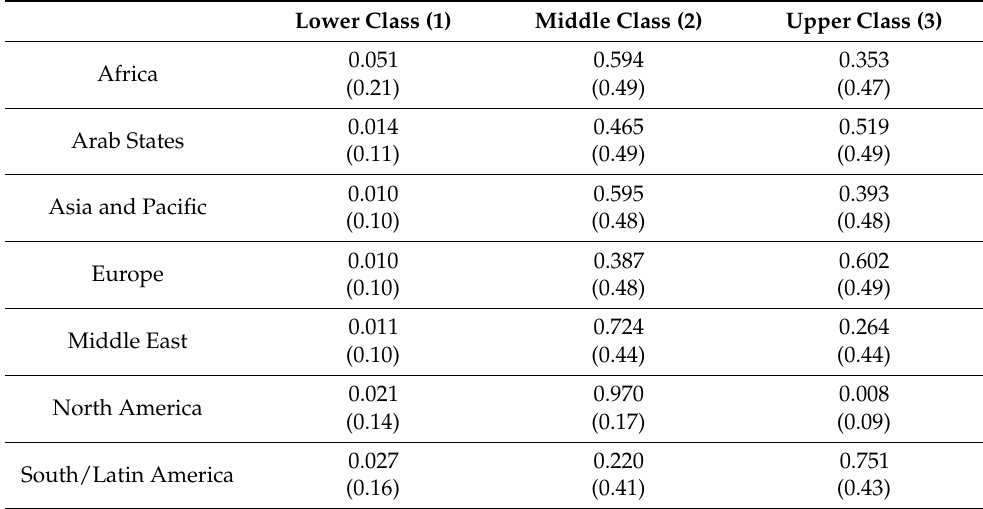
Table A1. Descriptive statistics: distribution by hypothesized income class by